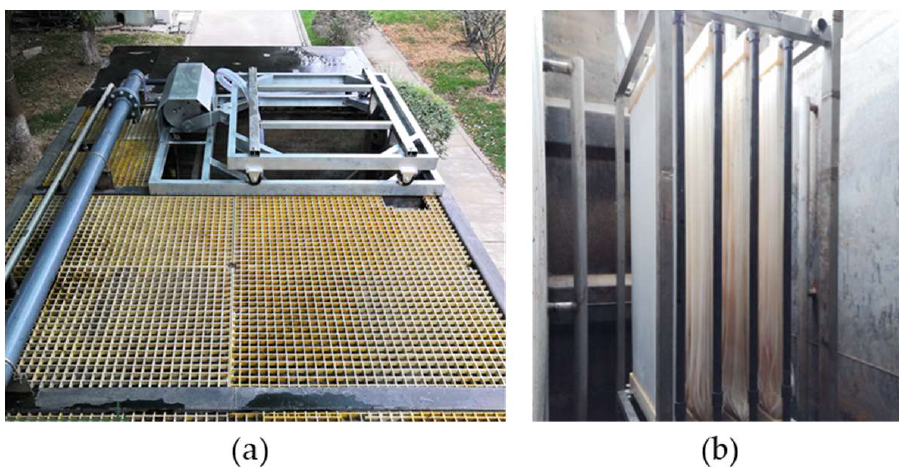
Figure 1. ( a ) The device for reciprocating motion in the pilot-scale LEP-N-MBR system; ( b ) The membrane module in the pilot-scale LEP-N-MBR system.